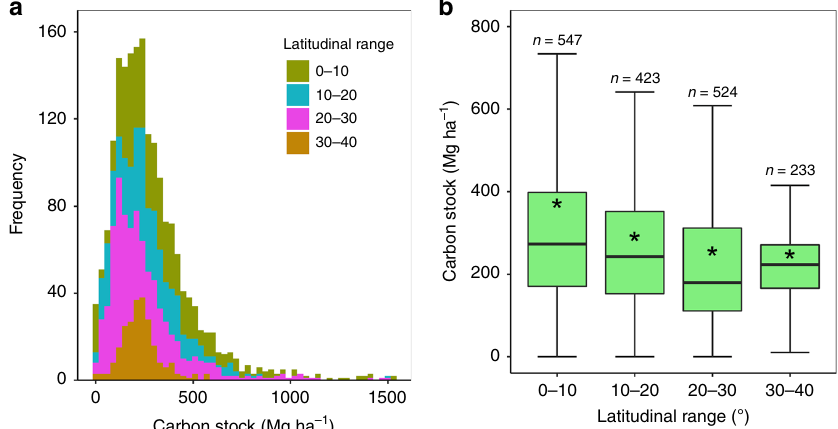
Fig. 2 Latitudinal comparison of sediment organic carbon stocks in mangroves. a Latitudinal frequency distribution of sediment OC stocks. b A whisker plot of sediment OC stocks. The stars in the whiskers show the mean sediment OC stock. The lower and upper hinges correspond to the fi rst and third quartiles (i.e., the 25th and 75th percentiles), respectively. The lower and upper whiskers denote the lowest and highest values within 1.5 times inter- quartile ranges from the fi rst and third quartiles, respectively.